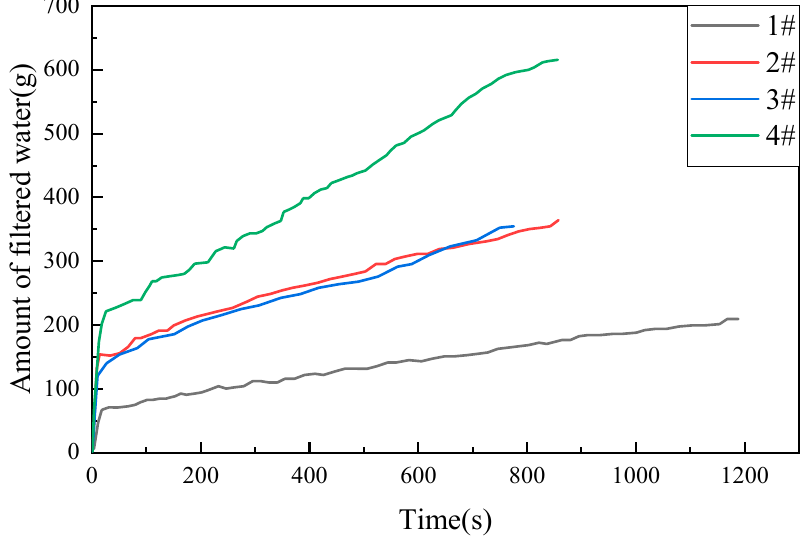
ff erent mud water filtration capacity in stratum G1. Figure 9. Comparison of different mud water filtration capacity in stratum G1. Figure 8. Comparison of di